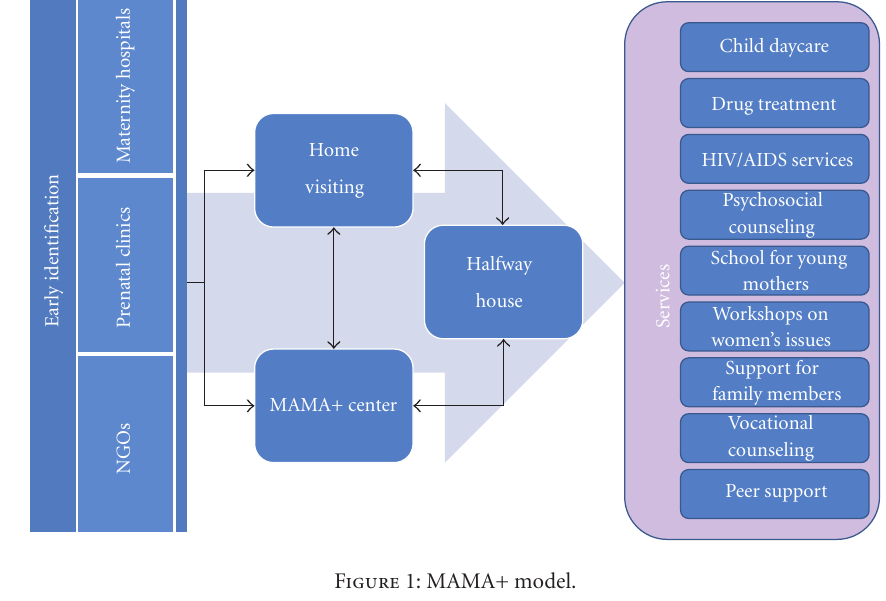
Figure 1: MAMA+ model.